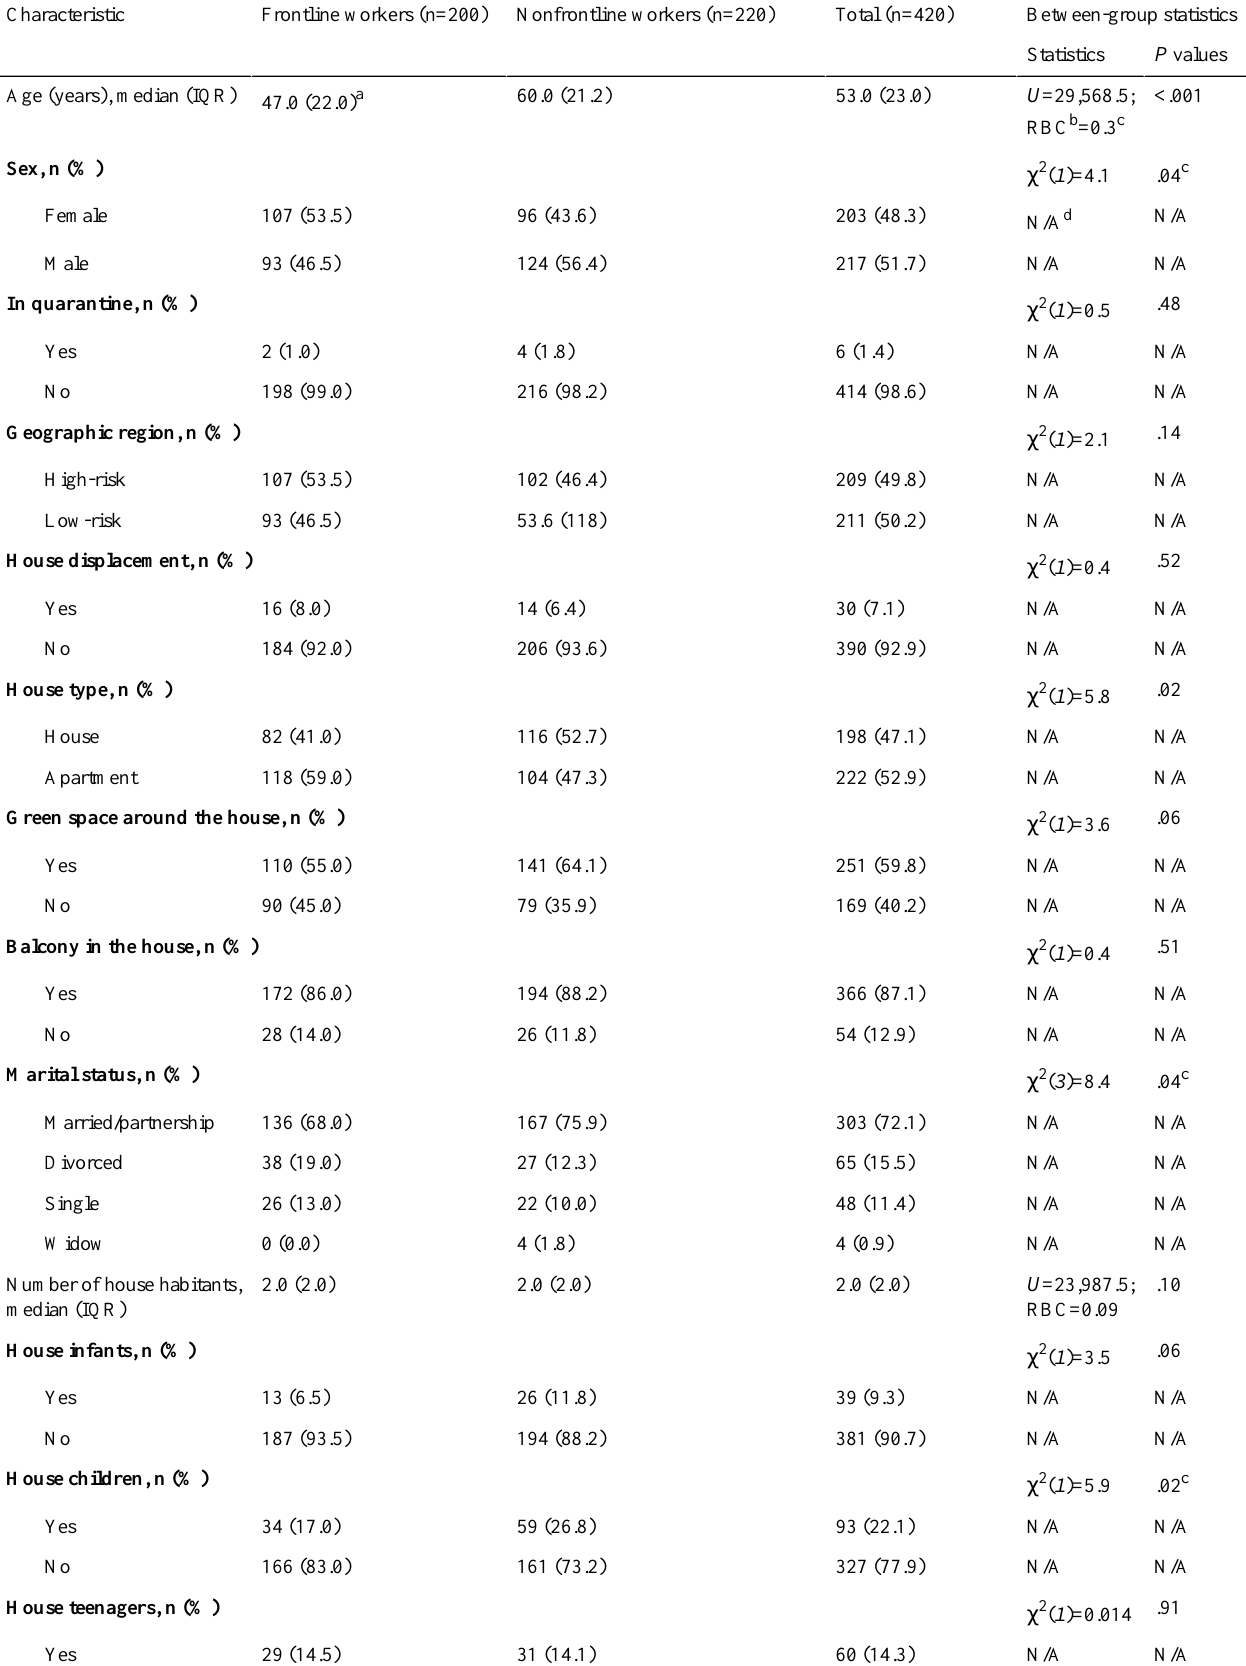
Table 1. Demographic data of the Portuguese physicians at the frontline and those not at the frontline during the COVID-19 pandemic (May 4-25, 2020), along with the statistics for between-group comparisons (Mann–Whitney U values for scalar variables and χ 2 values for categorical